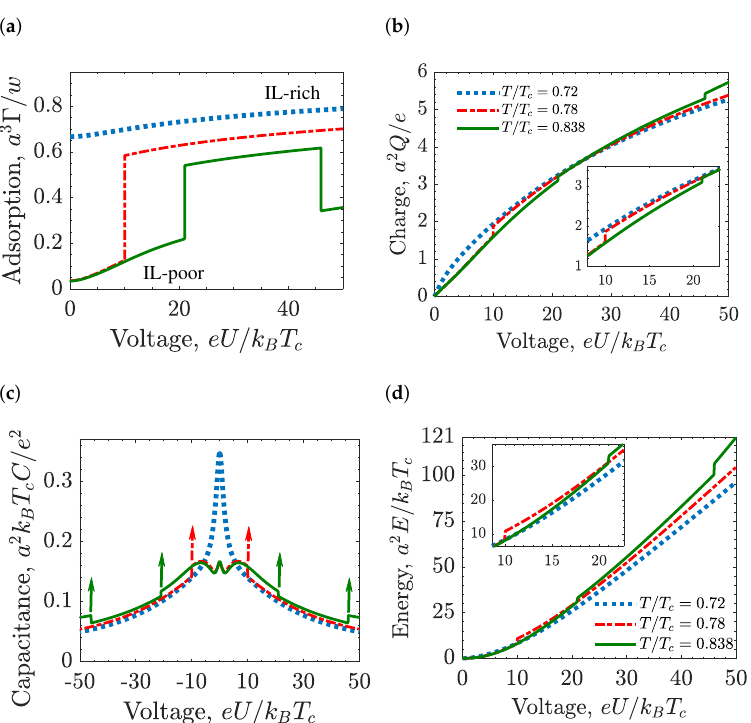
Figure 9. Voltage-induced capillary ionization and charging of the slit mesopores. ( a ) Amount of IL adsorbed in the pore, Γ (see Equation (9)). ( b ) Accumulated charge in the pore as a function of the applied voltage. ( c ) Differential capacitance. The vertical arrows indicate that capacitance diverges at the capillary ionization transition. ( d ) Stored energy. In all plots the pore width w = 20 a , chemical potential µ / k B T c = − 4.57 and ionophilicity a 3 h s / ξ 0 = 0.25, where a the ion diameter, and ξ 0 is the bare correlation length. For common values of the ion diameter a = 0.7 nm and room temperature for T c , the various units are: thermal voltage e / k B T c ≈ 26 mV for voltage, e / a 2 ≈ 2 e nm − 2 ≈ 32 µ Ccm − 2 for accumulated charge, thermal electric capacitance e 2 / ( k B T c a 2 ) ≈ 620 µ Fcm − 2 for capacitance, and k B T c / a 2 ≈ 0.84 mJcm − 2 ≈ 0.23 nWcm − 2 for